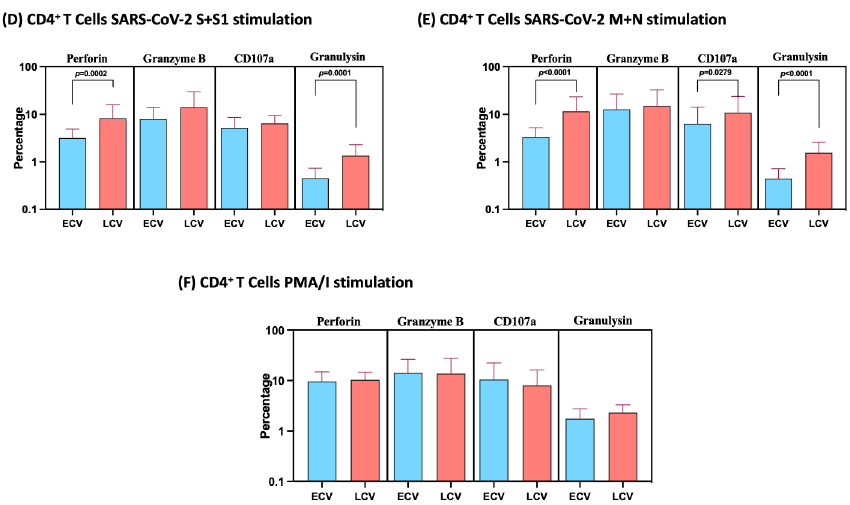
Figure 3. Enhanced frequencies of CD4 + T cells expressing cytotoxic markers in late convalescent COVID-19 individuals. PBMCs were cultured with media alone or SARS-CoV-2 or control antigens for 12 h and the baseline and antigen-stimulated frequencies of cytotoxic marker expressing CD4 + T cells were determined in early convalescent (ECV) COVID-19 ( n = 20) and late convalescent (LCV) COVID-19 individuals ( n = 20). The frequencies of cytotoxic marker expressing CD4 + T cells in early convalescent and late convalescent individuals (A ) Gating strategy and representative plots for CD4 + T cells expressing cytotoxic markers. ( B ) at baseline as well as in response to stimulation with ( C ) SARS-CoV-2 WCL, ( D ) SARS-CoV-2 S+S1 peptide pools, ( E ) SARS-CoV-2 M+N peptide pools and ( F ) PMA/Ionomycin were measured by flow cytometry. The bars represent the geometric mean values. Net frequencies were calculated by subtracting baseline frequencies from the antigen- induced frequencies for each individual. p values were calculated using the Mann–Whitney test. Any comparison that is not labelled with a p value is statistically non-significant.